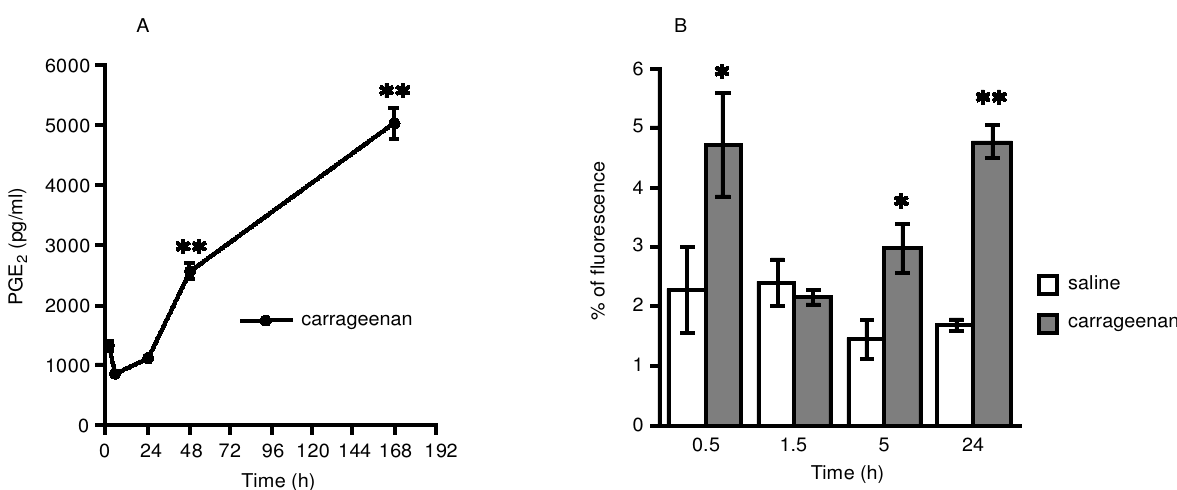
FIG. 3. Time course of PGE 2 (panel A) and plasma exudation (panel B) in carrageenan-induced in¯ ammation. Animals were pretreated with 1 ml of sterile saline or 1 ml of 1% carrageenan in sterile saline. In saline-treated animals PGE 2 was below the detection limit which was 20 pg ml. For the plasma exudation experiments FITC-BSA (0.6 mg mouse dissolved in 0.2 ml mouse of saline) was injected in the tail vein of animals 30 min before they were killed. Plasma exudation was expressed as a percentage of ¯ uorescence in the pouch in relation to serum. Data are the mean SD of at least eight animals. P < 0 05, P < 0 01 according to Duncan’s test for multiple